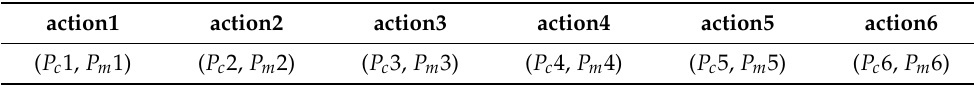
Table 4. The corresponding form of actions and parameters in the genetic